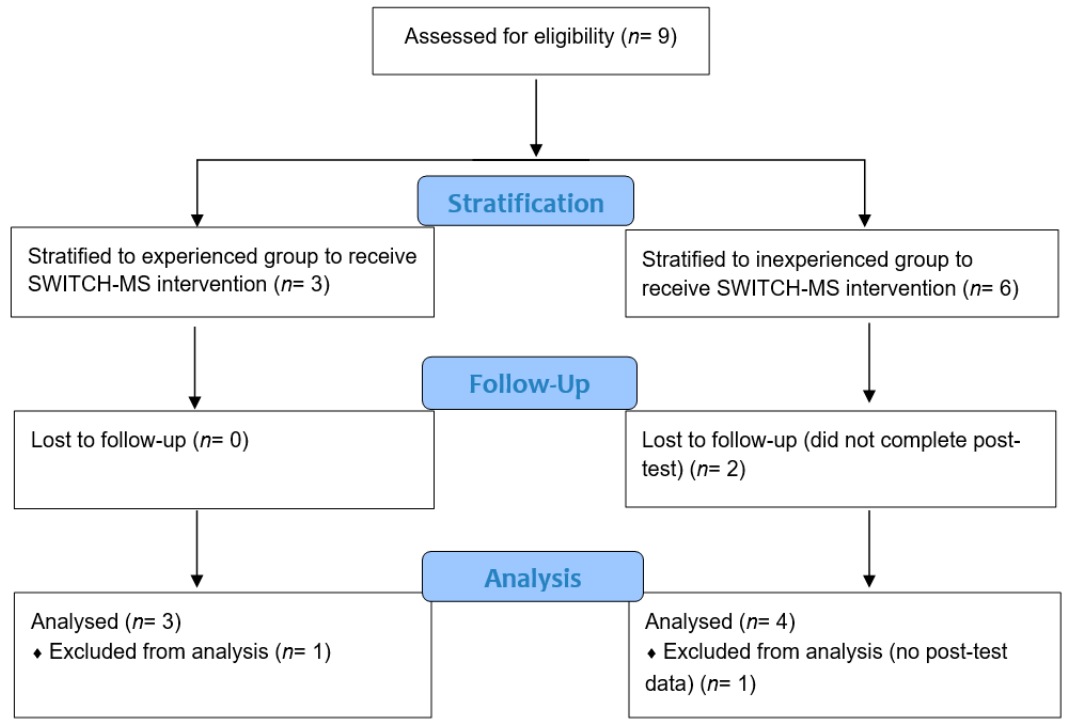
Figure 1. CONSORT Flow Chart for Enrollment. Note. The study followed the effectiveness- implementation hybrid type 3 quasi-experimental design.